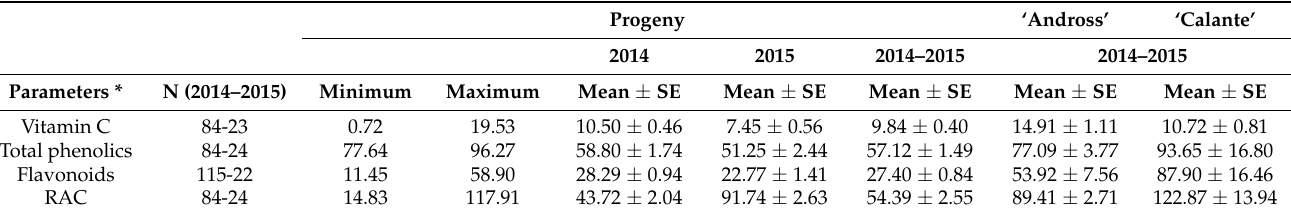
Table 5. Antioxidant compound contents and relative antioxidant capacity in flesh tissue of all the genotypes studied. N represents the number of the biological replications studied each year (2014–2015). Minimum, maximum, mean values ± standard error of all the hybrids derived from the ´ Andross’ × ´ Calante’ cross and both parents, ‘Andross’ and ‘Calante’, evaluated in 2014 and 2015. For each genotype, means are from N = 2–6 replicates. Progeny